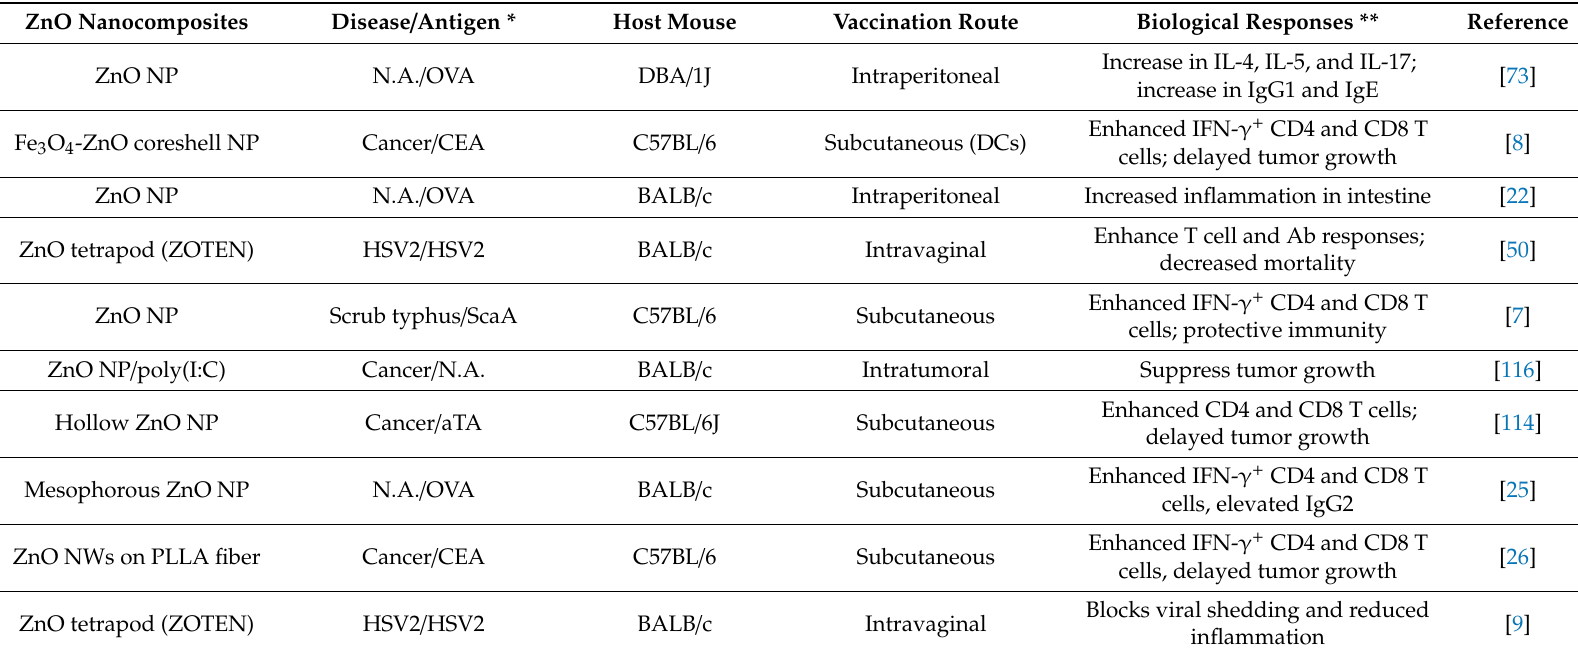
Table 1. Application of ZnO nanocomposites in development of vaccines and cancer immunotherapy in